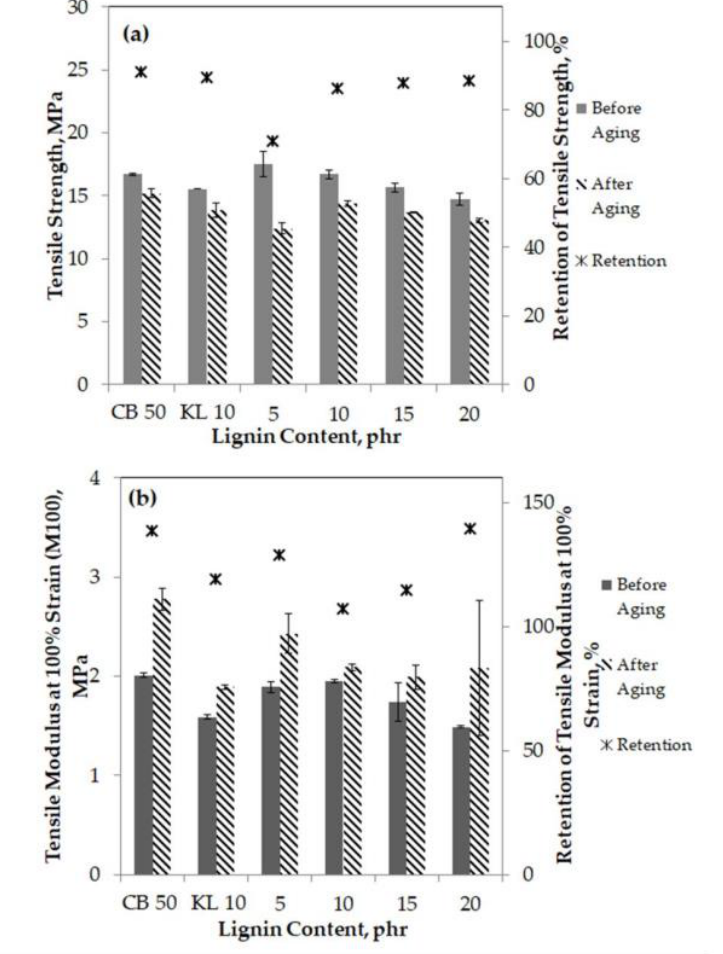
Figure 8. The effect of hydroxymethylated kraft lignin content on the retention of ( a ) tensile strength and ( b ) tensile modulus at 100% strain in lignin-filled NR/BR compounds. Reproduced from [63], with the permission of MDPI.